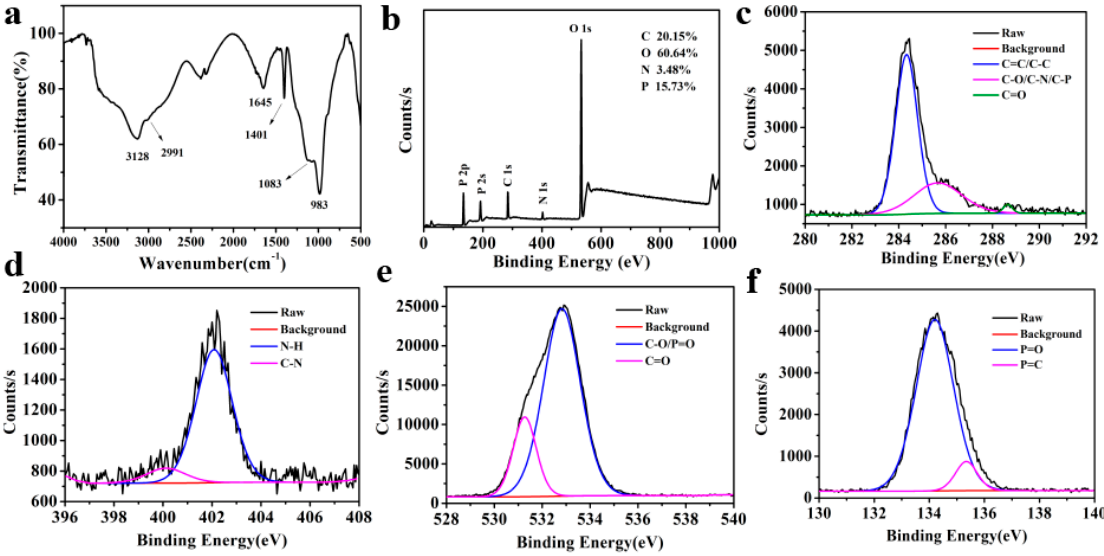
Figure 2. ( a ) The FTIR spectra of P-doped CQDs. ( b ) The XPS spectra of P-doped CQDs. High resolution XPS spectra of P-doped CQDs: ( c ) C 1s, ( d ) N 1s, ( e ) O 1s, and ( f ) P 2p spectra.